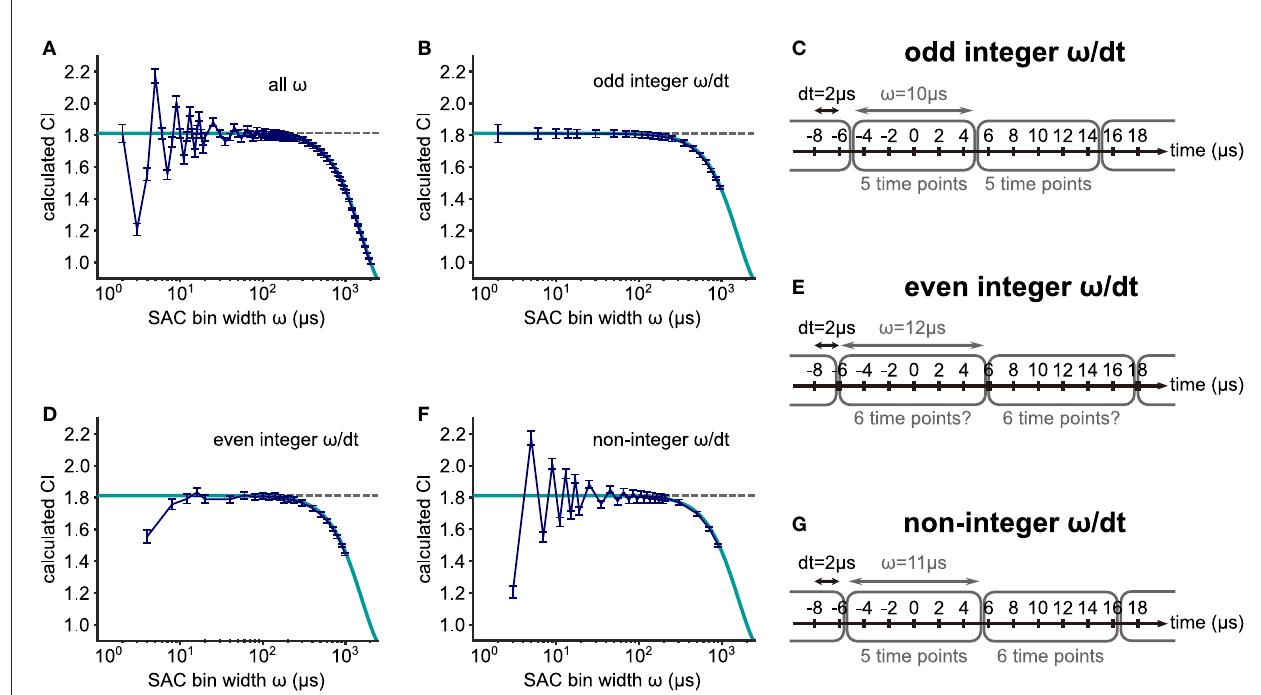
FIGURE 7 | Effects of the SAC bin width ω on CI. (A) CI values for 88 different SAC bin widths. Spike trains simulated with a von Mises distribution (frequency = 500 Hz; concentration κ = 1.5157; target VS = 0.60; mean spike rate = 200 spikes/s; time step dt = 0.002 ms; duration = 100 ms; and 400 repetitions) were used. The amount of error or bias in CI depends on the ratio between the spike sampling time step dt and the SAC bin width ω , namely ω/ dt, being either (B) odd integer, (D) even integer or (F) non-integer. The gray dotted line represents the estimated CI (= 1.8120) based on the underlying κ value. The dark blue line shows the mean CI values with error bars indicating the standard deviation for the simulated spike trains. The theoretical decay of CI with large ω is illustrated by the cyan curve (see Equation 7). (C,E,G) Schematic illustrations for the effects of the SAC bin width ω . (C) For an odd integer ratio ω/ dt, each bin has the same number of time points. (E) When ω/ dt is an even integer, the number of time points in each bin may or may not be equal depending on the rounding algorithm. (G) For a non-integer ω/ dt, the number of time points differs between two neighboring